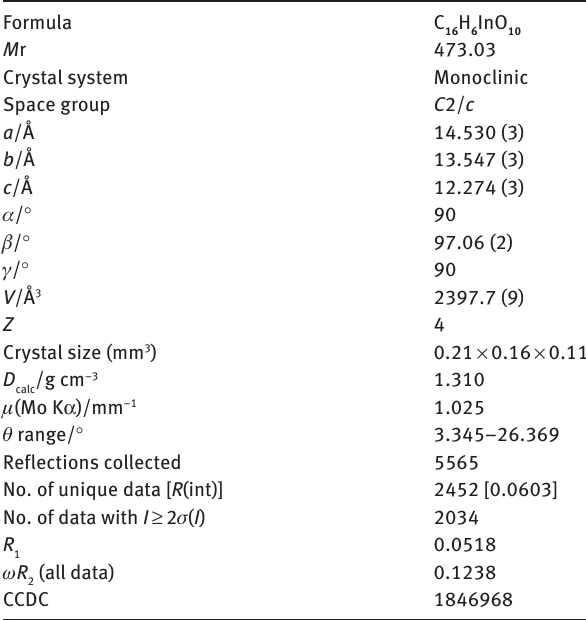
Table 1: Crystallographic parameters for compound 1 .